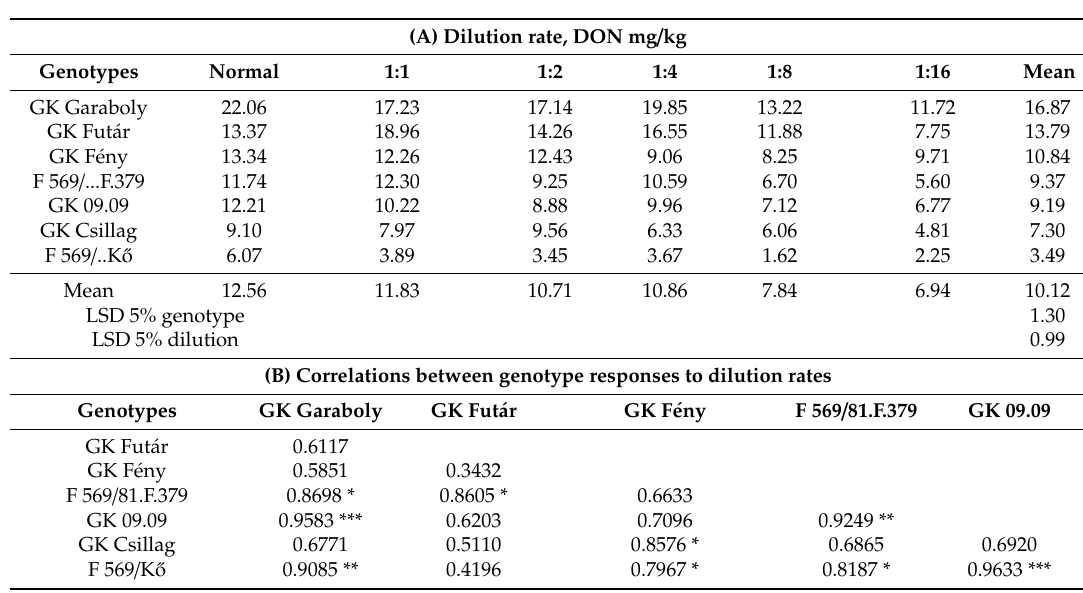
Table 8. Reduction of the aggressiveness of the winter wheat genotypes at di ff erent dilutions across isolates and experiments, the measure by DON contamination (mg / kg) 2013–2014. ( A ) Dilution rate, DON mg / kg. ( B ) Correlations between genotype responses to dilution rates.